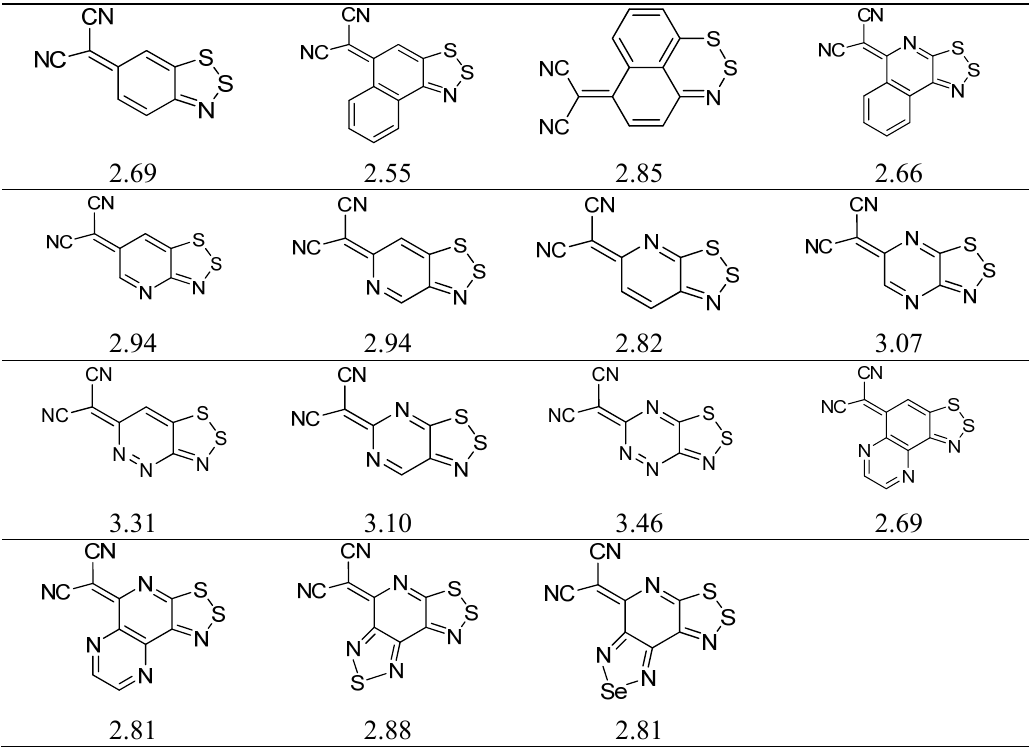
ylidene)malononitrile and its selected derivatives